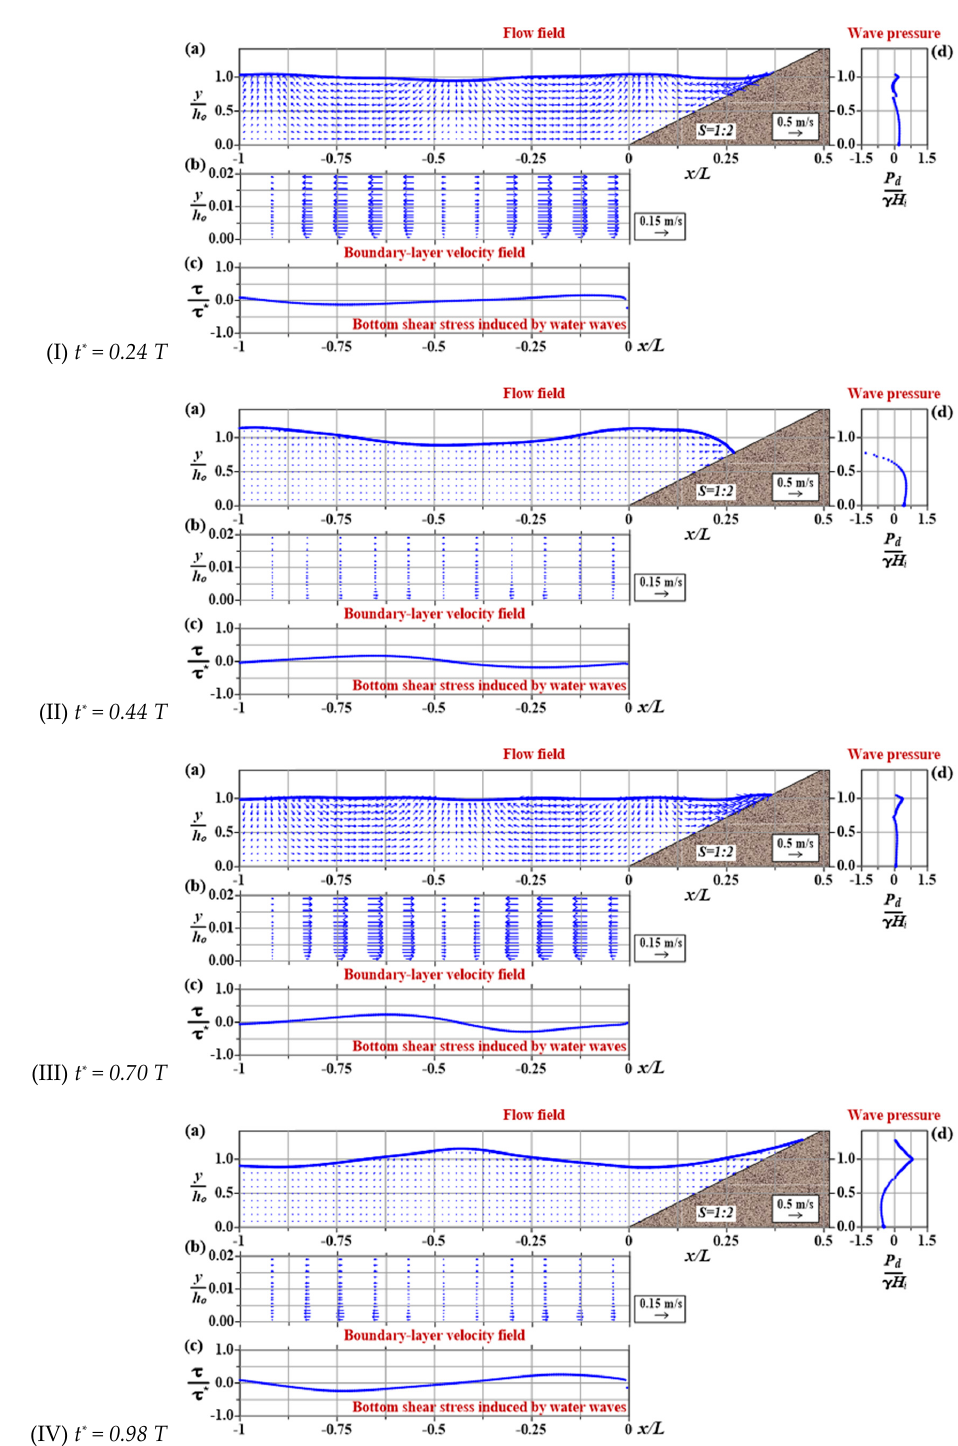
Figure 9. Snapshots of the periodic incident wave ( Ur = 4.7) propagation on a steep seawall with a slope of 1:2. ( a ) The free − surface and flow field velocity; ( b ) the boundary − layer flow; ( c ) the bottom shear stress prior to the seawalls; ( d ) the wave pressure on the